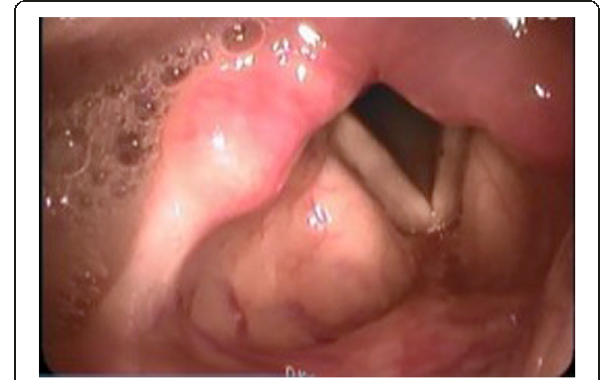
Fig. 1 Laryngofiberscopic view of the oropharynx. Adhesion of the anterior tonsillar pillars and inferior tonsillar fossa to the tongue base is observed. Uvula is obliterated